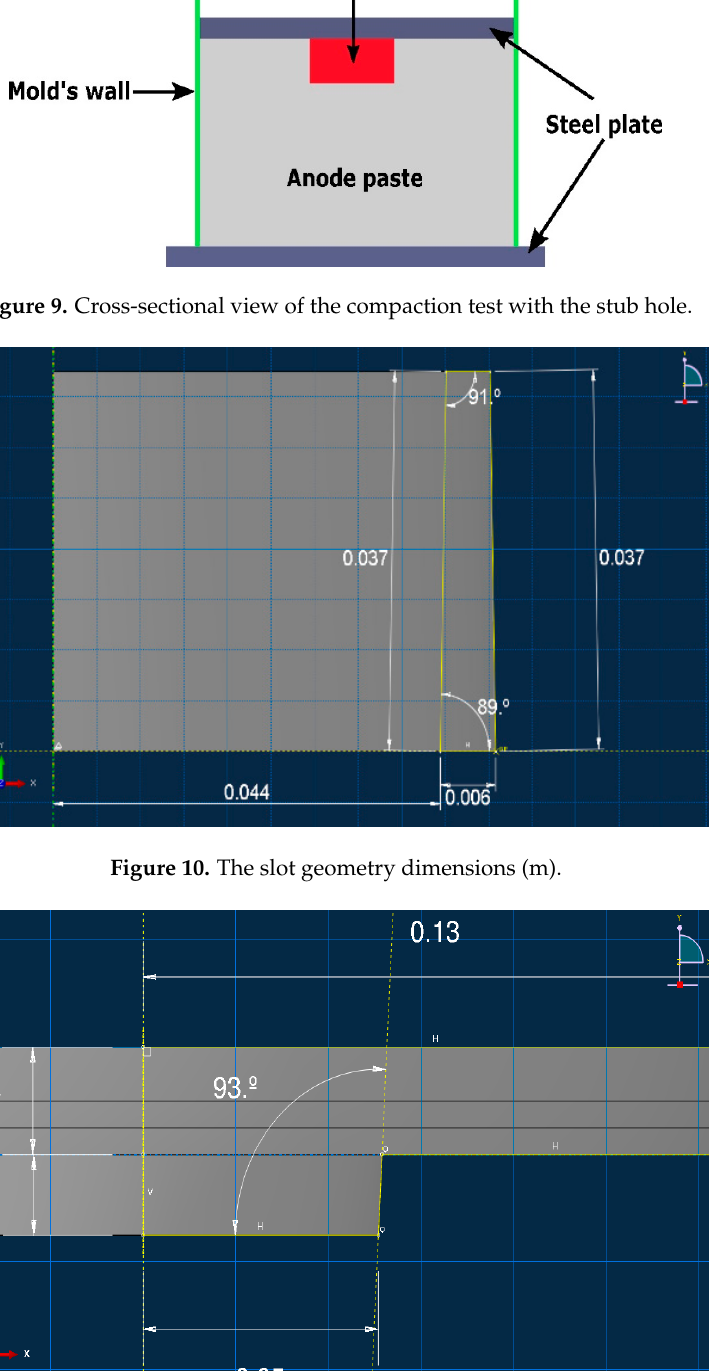
Figure 11. The stub-hole geometry dimensions (m).